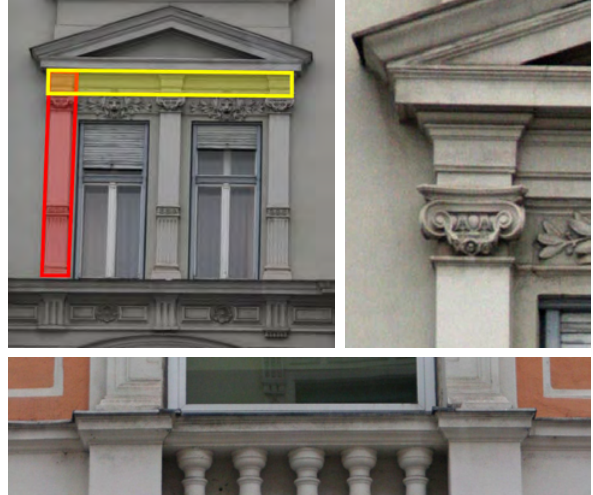
Figure 11: Examples of a window with overlapping structures. The pilaster (red) overlaps the architrave (yellow). In the over- lapping area, the moulding of the architrave runs across a contin- uation of the capital of the pilaster. In the window at the bottom, a ledge that runs across the whole fac¸ade also serves the purpose of a window sill.